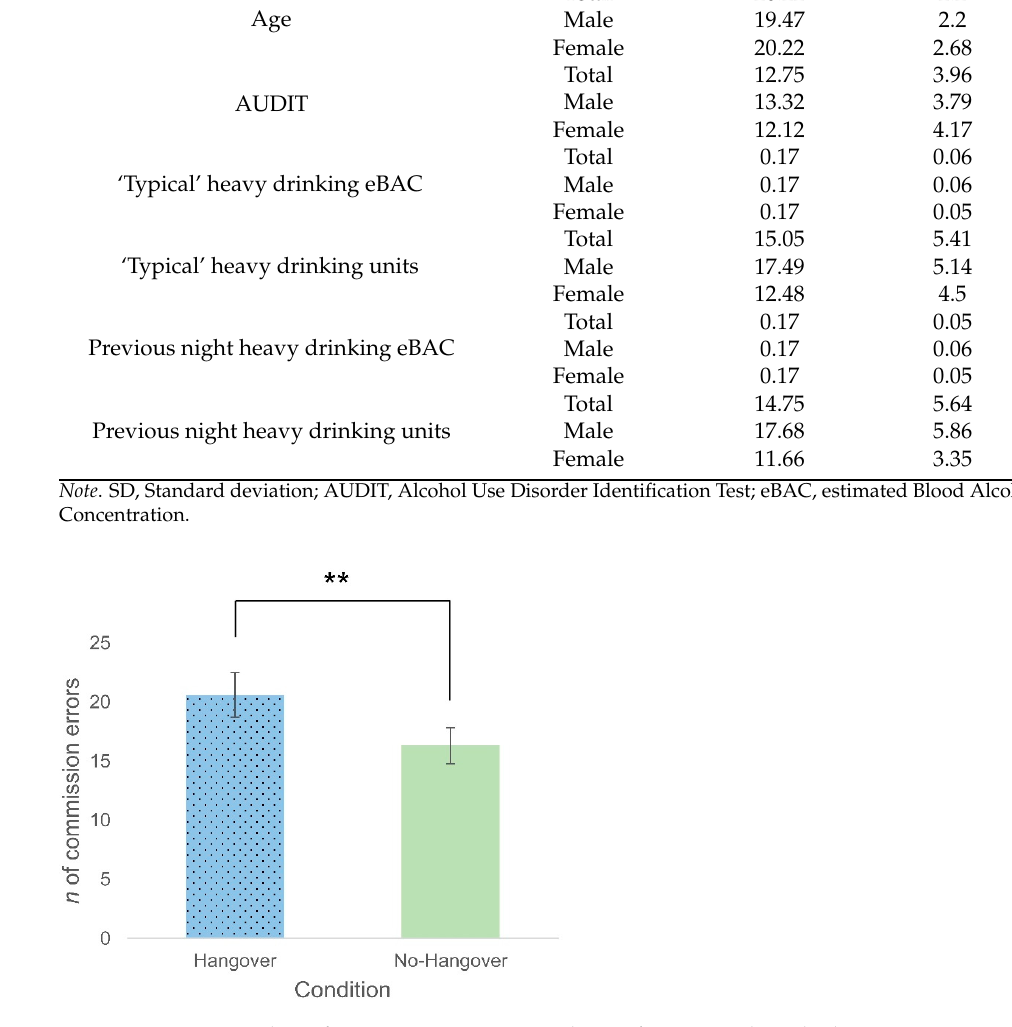
Figure 2. Mean number of commission errors on the Go/No-Go task in the hangover versus the no-hangover condition. A greater number of commission errors were made in the hangover condition compared to the no-hangover condition, indicating poorer response inhibition during hangover. Error bars represent ± 1 standard error of the mean. ** represent a significant